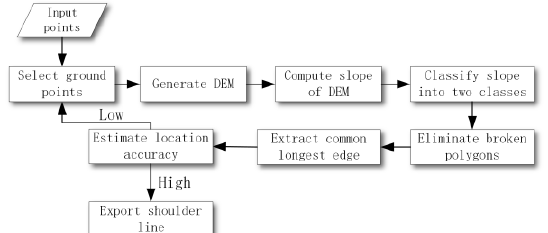
Figure 4. Workflow of shoulder line extraction based on point